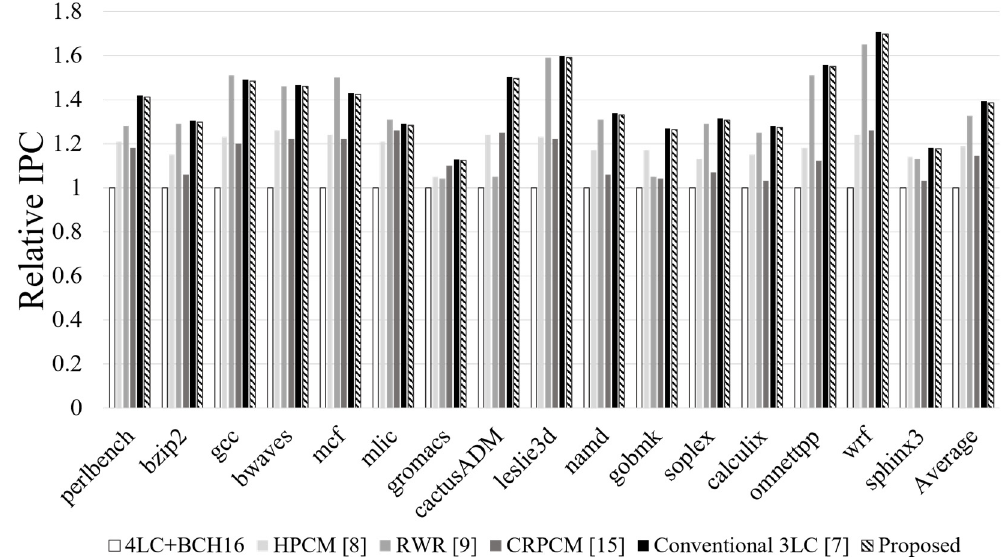
Figure 11. Comparison of performance with respect to relative IPC between proposed methods and previous studies.